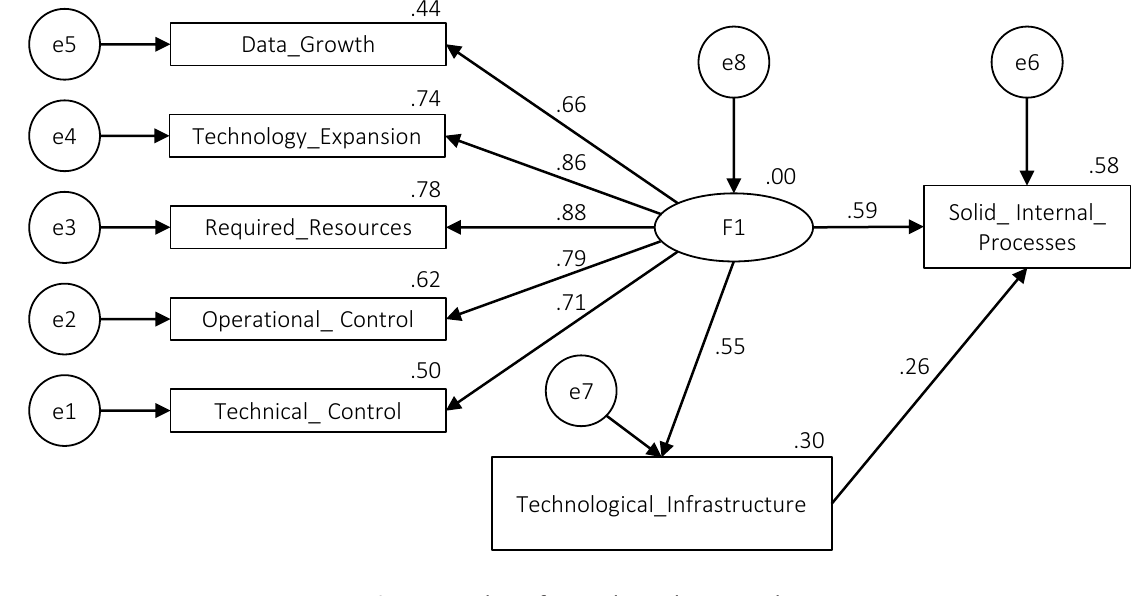
Figure 2. Chart for path analysis